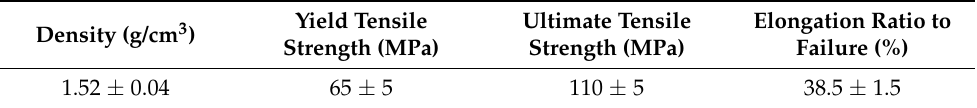
Table 1. Density and mechanical properties of the as-cast Mg–8%Li alloy. Density (g/cm 3